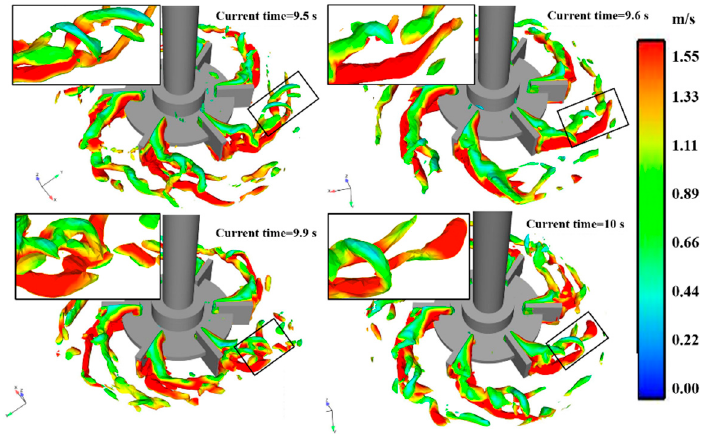
Figure 6. The instantaneous structure of the turbulent vortices.